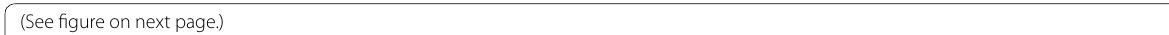
heights(See figure on next Fig. 4 Graphical depiction of method for computing times and heights of high waters and low waters on November 28 and 29, by means of interpolation of predicted and observed heights outside that time window. a Overview of tide table predictions (color) and gauged water levels (black curve and circles) November 26 to December 1, along with high waters and low waters computed in b . Each dotted line is a cubic spline fit to the four lunar-day sets of high waters and low waters, and the associated tide table predictions are keyed by color to Fig. 3. b Computation of times and heights for November 28 and 29 (bold) for each of the four lunar-day sets. The splines in a (dotted color lines) are reproduced separately in ( b ) for each set. Ratios of predicted intervals between lunar-day tides (upper bracket with each set) are projected onto a slightly adjusted timeline controlled at its ends by high water and low water times gauged November 27 and November 30, outside the time of the tsunami (lower bracket). Evaluating the splines at the computed times gives the computed